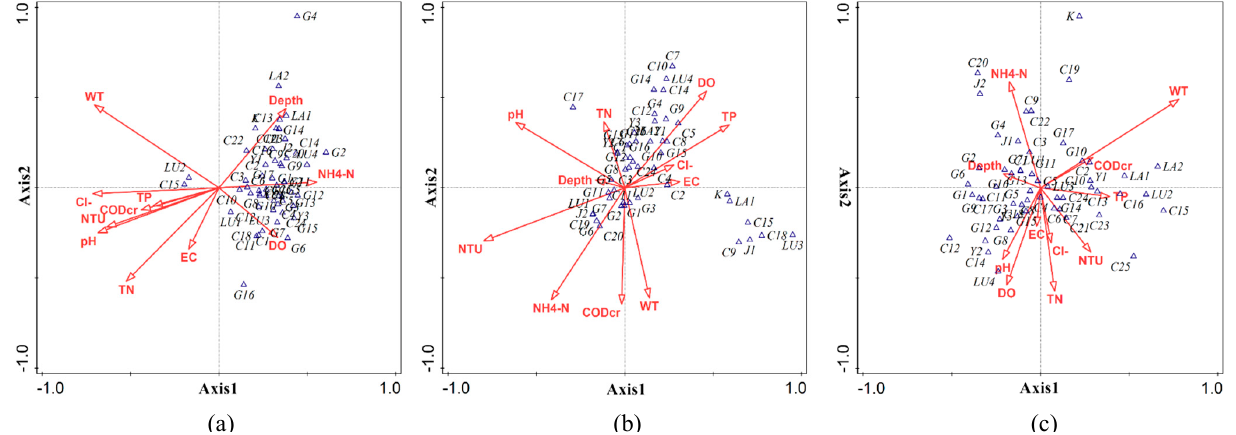
Figure 5. CCA between phytoplankton species and environmental factors: ( a ) lake area; ( b ) river area; ( c ) wetland area.